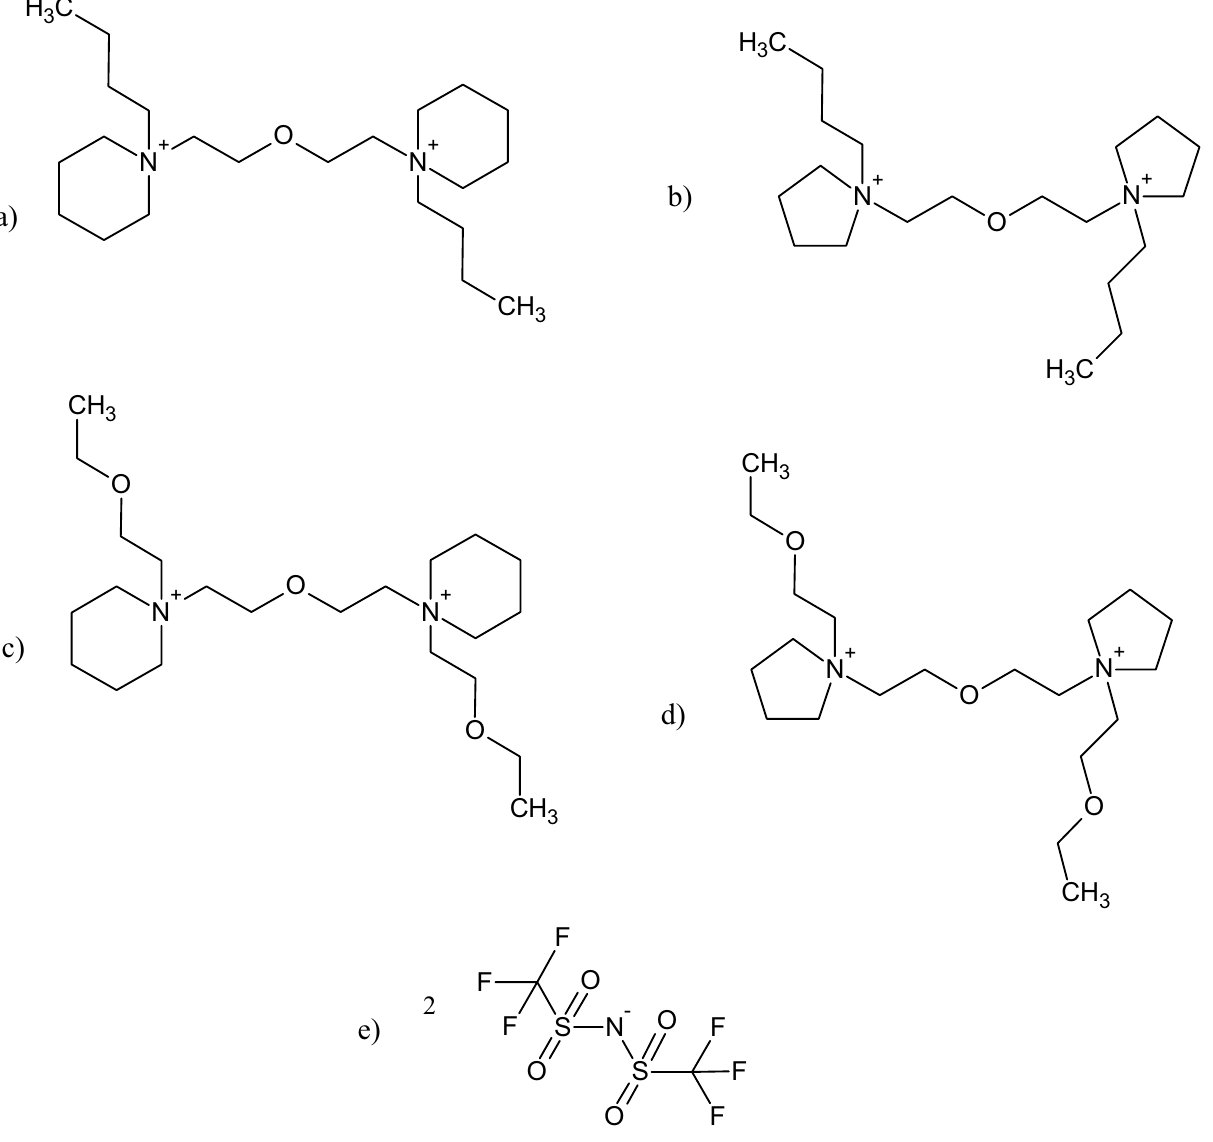
Figure 1. The ionic components of the GILs studied in this work: ( a ) 1,1–2-oxabutane-bis-1-butylpiperidinium, (C